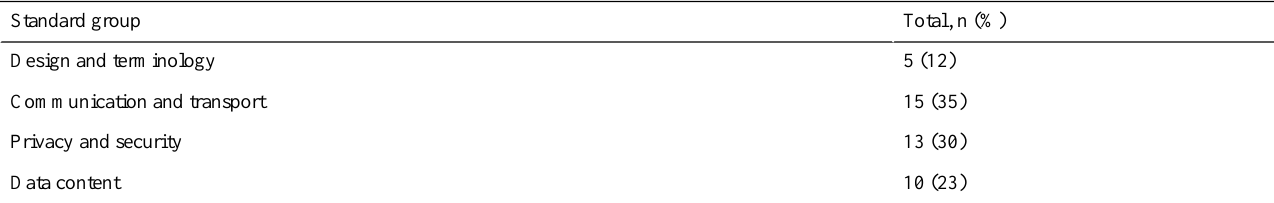
Table 1. Number of standards for each standard category identified